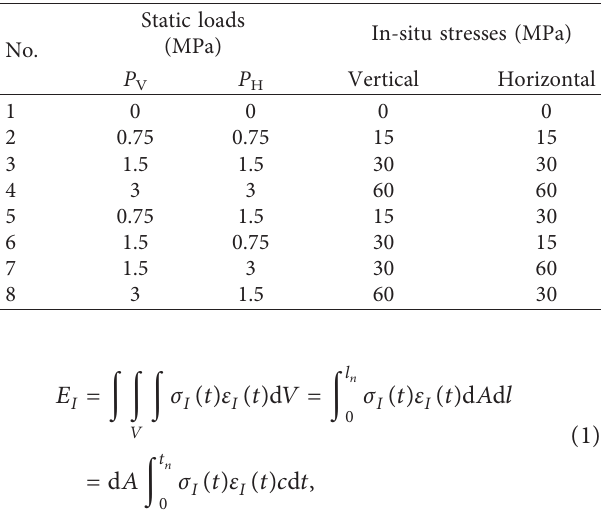
Figure 6: Schematic diagram of charge structure. Table 2: Boundary static loads of model test samples.